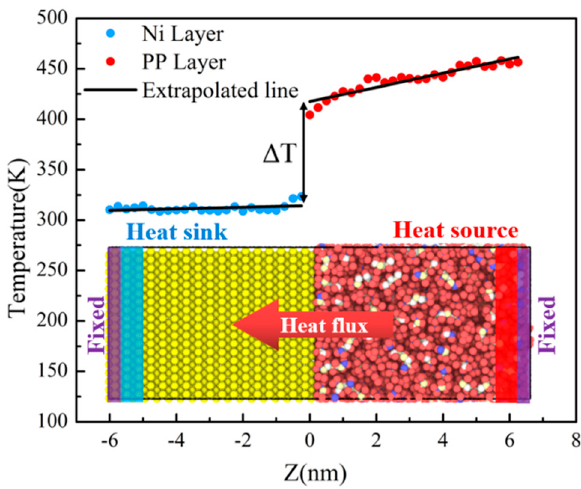
Figure 1. Non-equilibrium molecular dynamics (NEMD) simulation model for the polypropylene-nickel (PP-Ni) system and the temperature profile in a steady state.